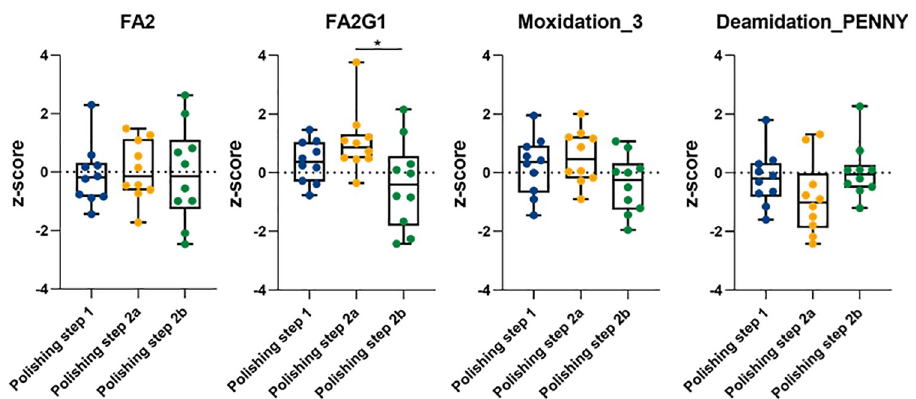
Fig 7. Level comparison for selected PQAs (FA2, FA2G1, Moxidation_3, Ndeamidation_3 or PENNY) monitored after purification using three different polishing resins, each one evaluated with 10 different buffer conditions. Polishing step 2a and 2b are two alternatives for the second polishing step. The values presented in the box plots are normalized according to the reference sample (z-score).